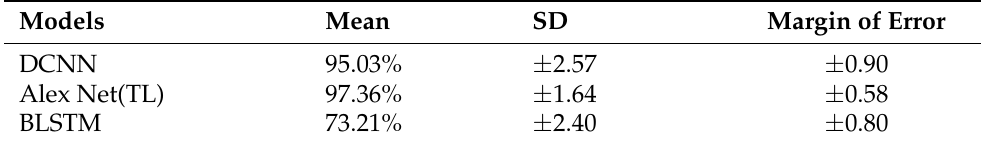
Table 9. Alphabet classification values of mean, standard deviation, and error.